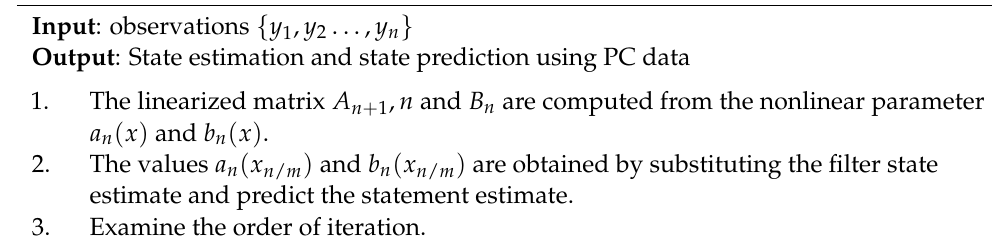
Algorithm 1: EKF for LiDAR PC